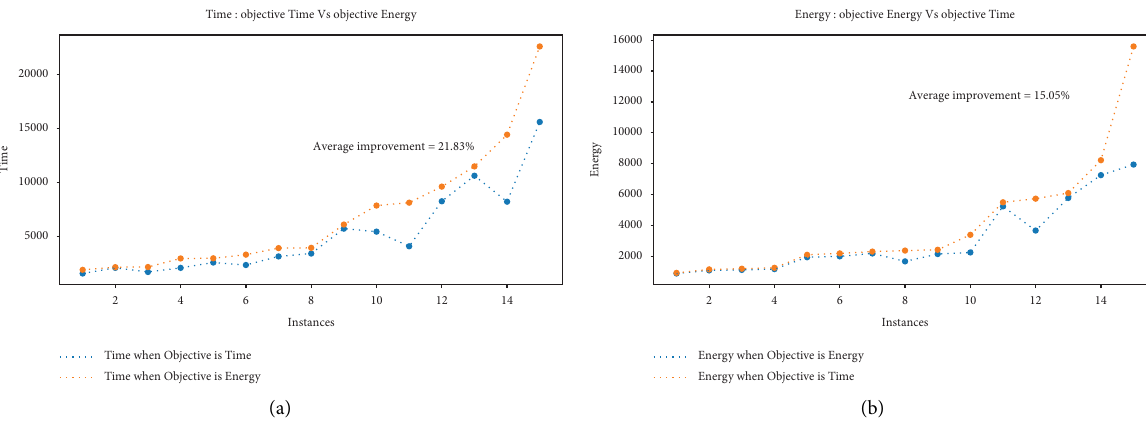
Figure 6: Times and energies comparison by changing the considered objective function. (a) Total consumed times relative to diferent objective functions. (b) Total consumed energies relative to diferent objective